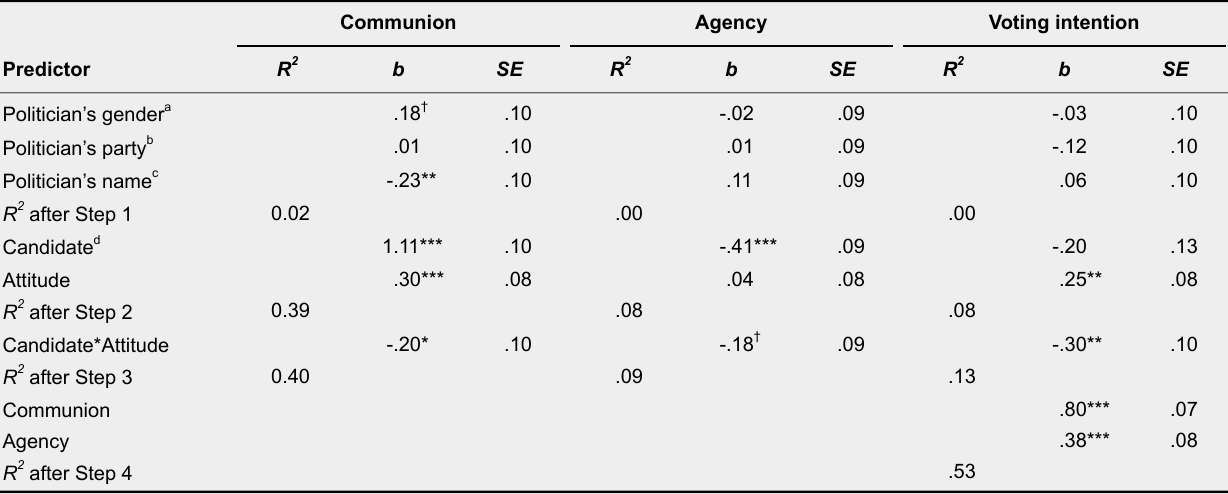
Regression-Based Moderations and Moderated Mediation in Study 1